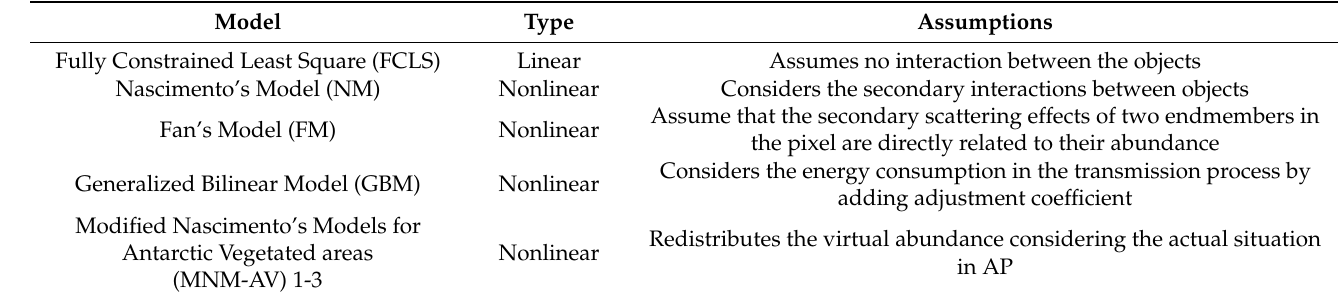
Table 2. Models used in the